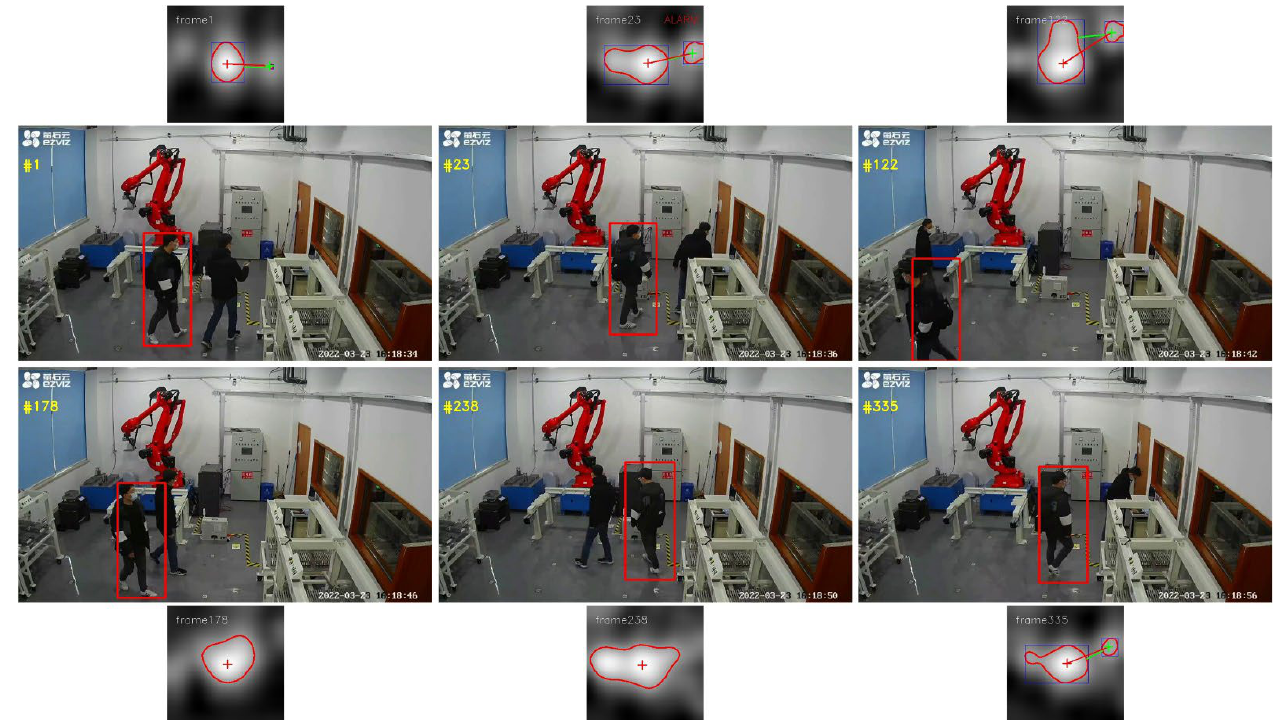
Figure 12. Qualitative results for some typical challenging scenarios.